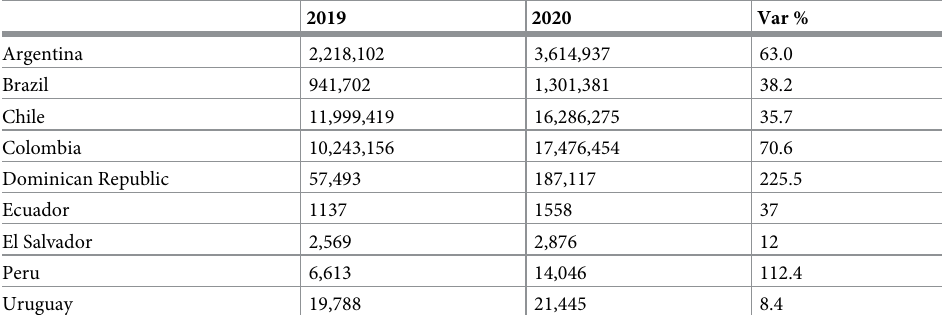
Note: The numbers refer to total expenses on “Social Inclusion and Reconciliation” (Colombia), “Social Security” (Argentina), “Social Development” (El Salvador), “Social Benefits” (Dominican Republic and Ecuador) and “Social Protection” (Peru, Chile, Brazil and Uruguay). Sources: Transparency Portal (Colombia, Peru and Uruguay),